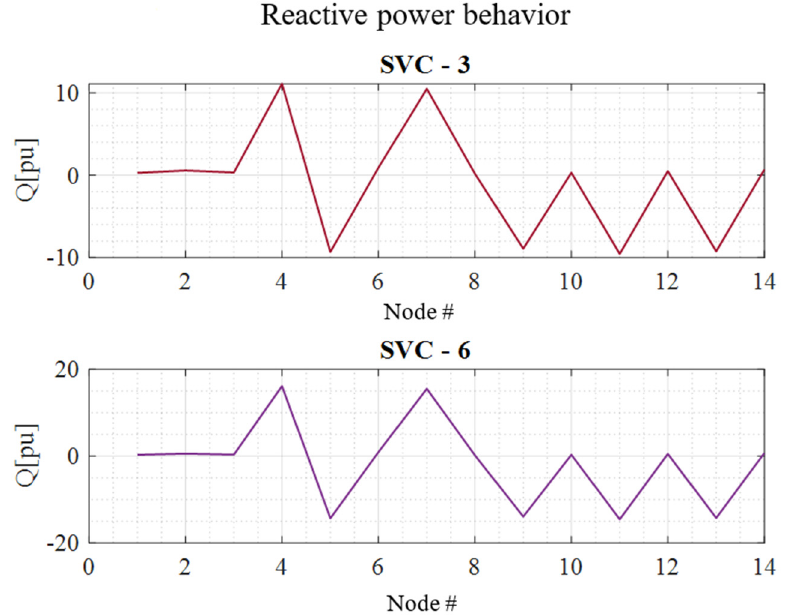
Figure 10. Profile of nodal reactive power in the IEEE 14-bus test system: SVC 3 and 6.